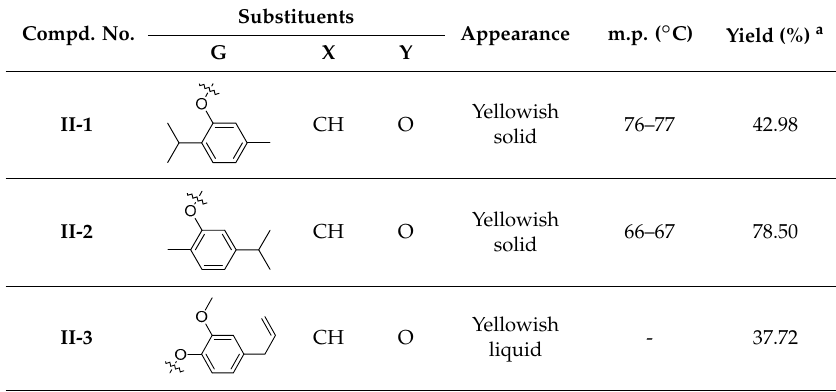
Table 1. The chemical structure of target compounds II-1 ~ II-17 .